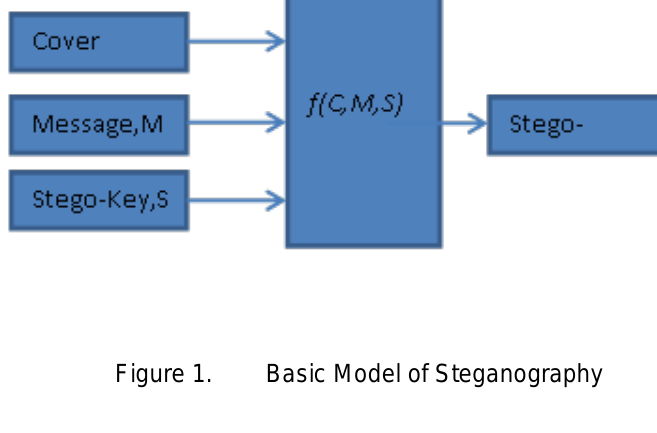
Figure 1. Basic Model of